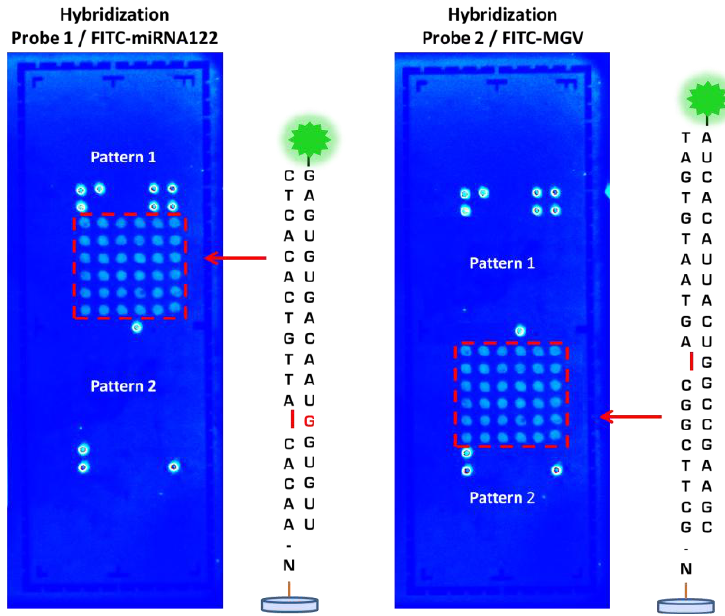
. Red square (pattern 1) CHO incorporation (showed CHO